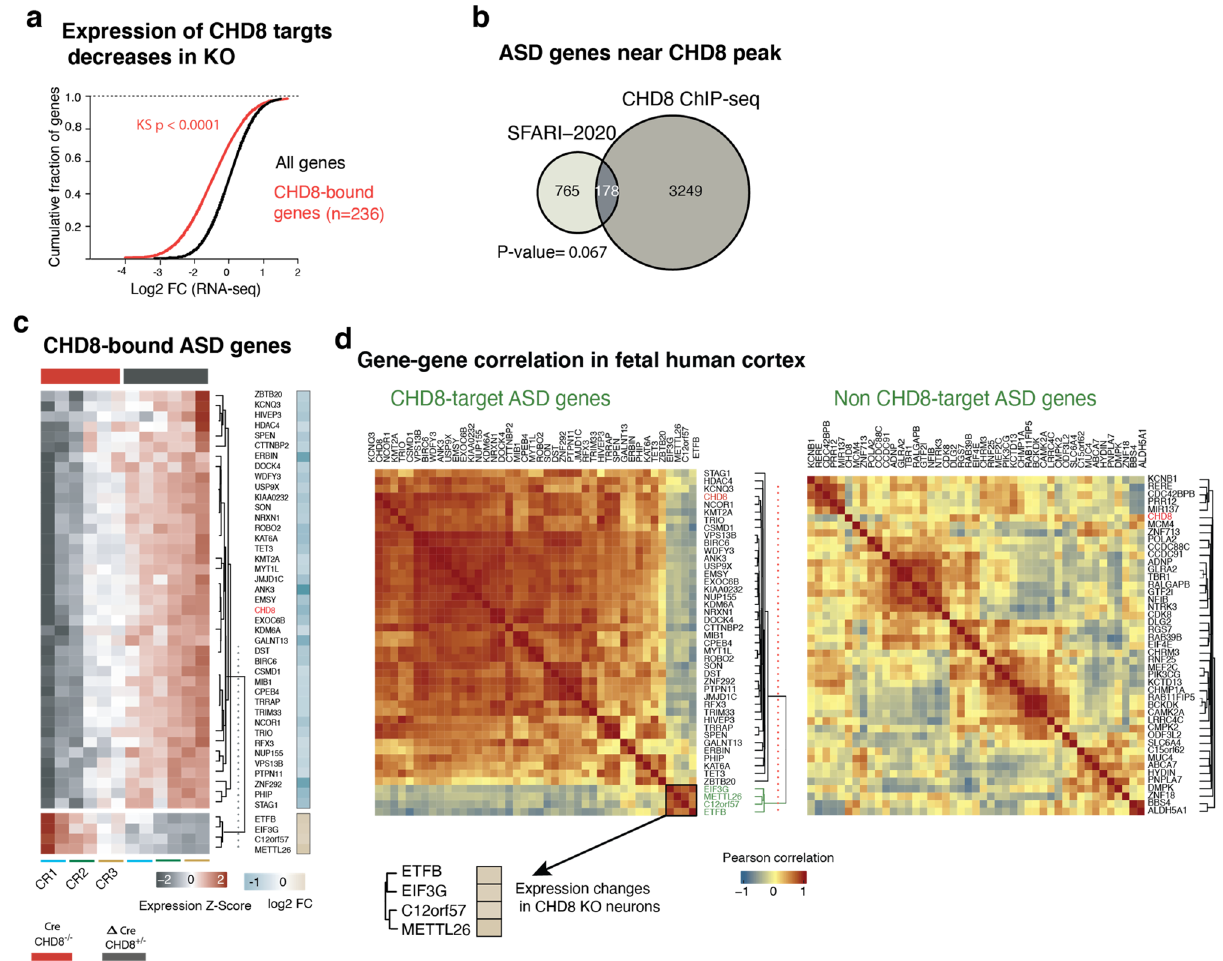
Figure 13. CHD8 positively regulates transcription of its target promoters and the ASD gene module that co-expresses in human brain. ( a ) Expression of genes with CHD8 peak at the ± 5 Kb of the promoters showed a marked decrease compared to control. ( b ) Overlapping of ASD genes from SFARI-2020 list and genes with CHD8 binding at promoters 46,47 . Significance of the overlapping calculated with the hypergeometric test. ( c ) Gene expression of CHD8-bound ASD genes with significant change in RNA-seq experiment. ( d ) correlation analysis of CHD8-target ASD genes (same gene set we discovered in “ c ”) within the human fetal cortex (12–37 CPW) is plotted. The clusters of similarly expressed genes led to the separation of the same gene modules shown in “( c )”. A separate module of non-CHD8 target autism gene was randomly selected for correlation analysis of the control